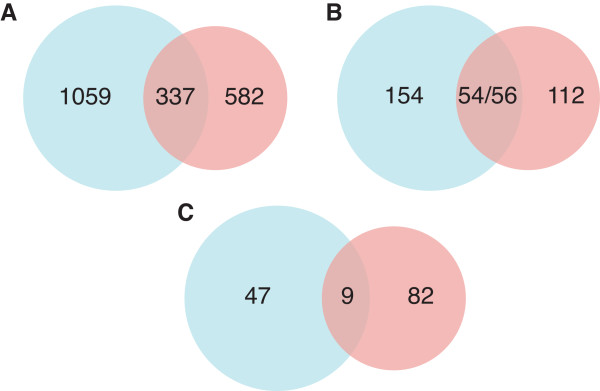
Overlap between miPALM predicted complexes using two large-scale PPI networks as inputs. A) Overlap between protein members in the predicted complexes. B) Overlap between complexes. C) Overlap between novel complexes. Blue, predicted complexes using HC PPI network; Red, predicted complexes using BioGRID PPI network.